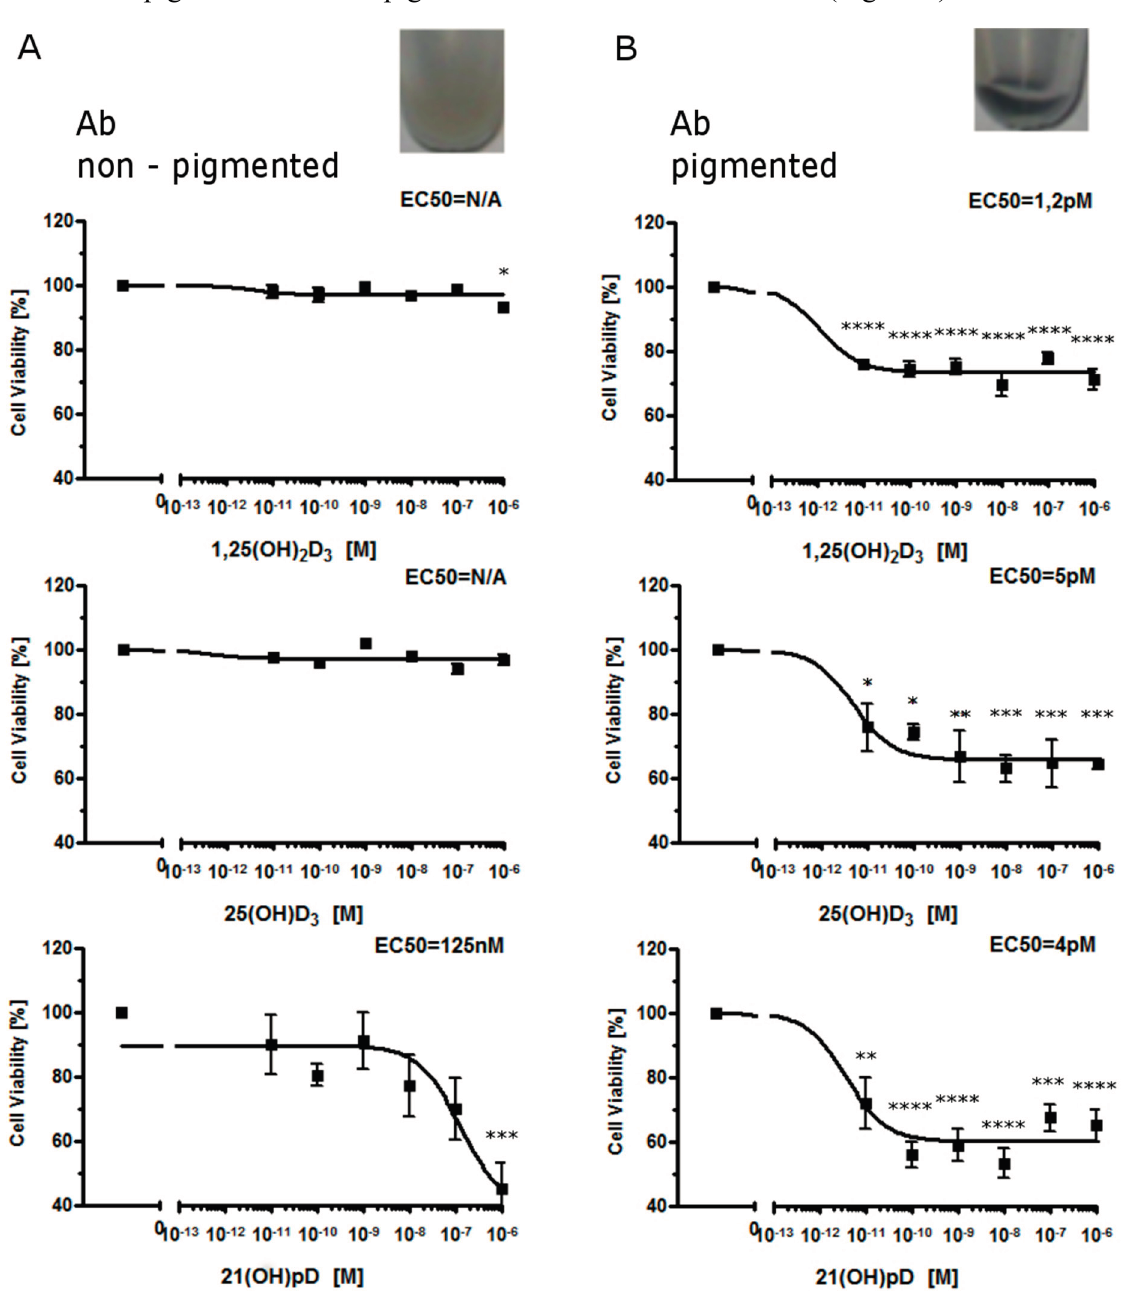
Figure 1. Inhibition of growth of hamster Ab melanoma cells by 1,25(OH) 2 D 3 , 25(OH)D 3 and 21(OH)pD. Non-pigmented ( A ) and pigmented ( B ) Ab cells (grown as described in Materials and Methods section) were treated with serial dilutions of Vitamin D analogs (0.01–1000 nM). The experiment was repeated with similar results. The amelanotic and melanotic phenotypes are shown as inserts. Data are presented as mean ± SEM ( n = 6). Statistical significance was estimated using t -test and presented as * p < 0.05, ** p < 0.005, *** p < 0.0005, **** p < 0.0001 vs.